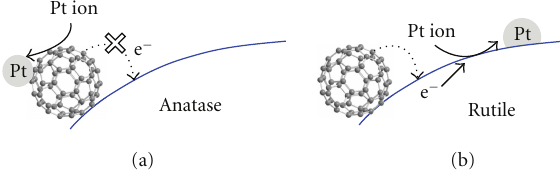
Scheme 3: Schematic illustrations of the photodeposition model of Pt particles on (a) the anatase-C 60 composite and (b) the rutile-C 60 composite under visible light